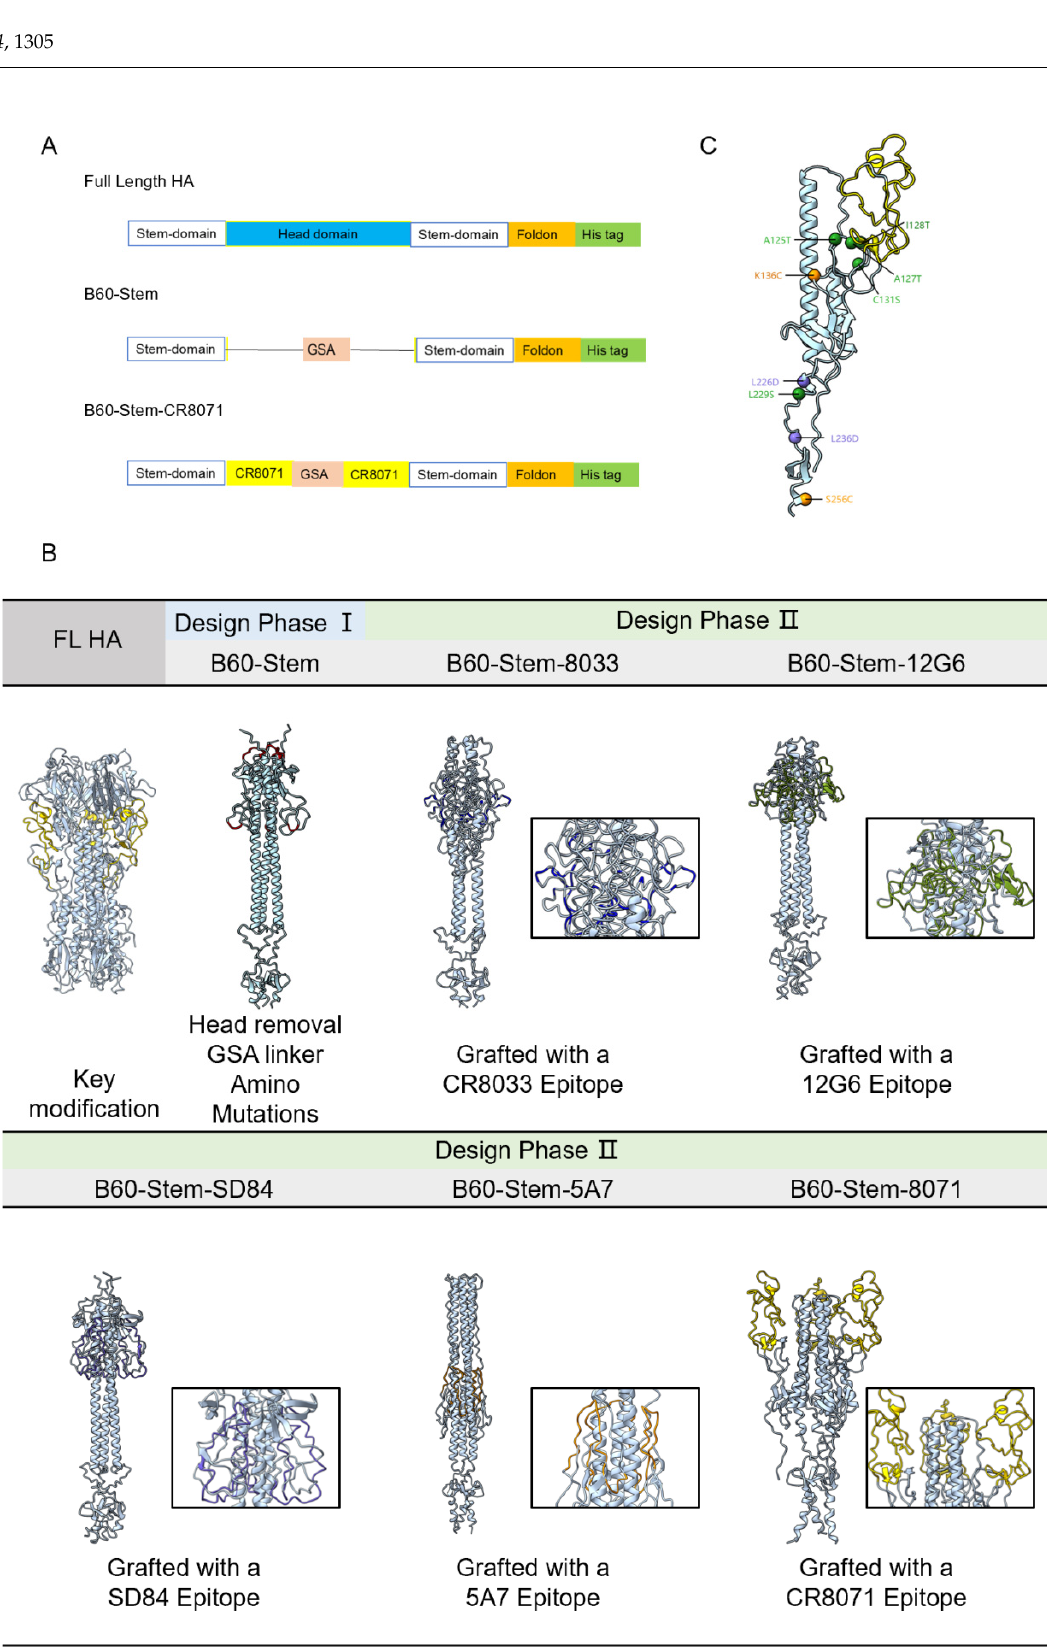
Figure 1. The design of the HA stem strategy and key candidates. ( A ) Schematic of full length, B60-Stem and B60-Stem-CR8071 HA (B/Brisbane/60/2008(Victoria lineage); PDB:4FQM). ( B ) The prediction model of each design phase by AlphaFold2. GSA linker was colored in red, CR8033 epitope (blue), 12G6 epitope (green), SD84 epitope (purple), 5A7 epitope (orange) and CR8071 epitope (yellow) (drawn by PyMOL modeling software). ( C ) Ribbon HA stem model with color-coded modifi- cations.